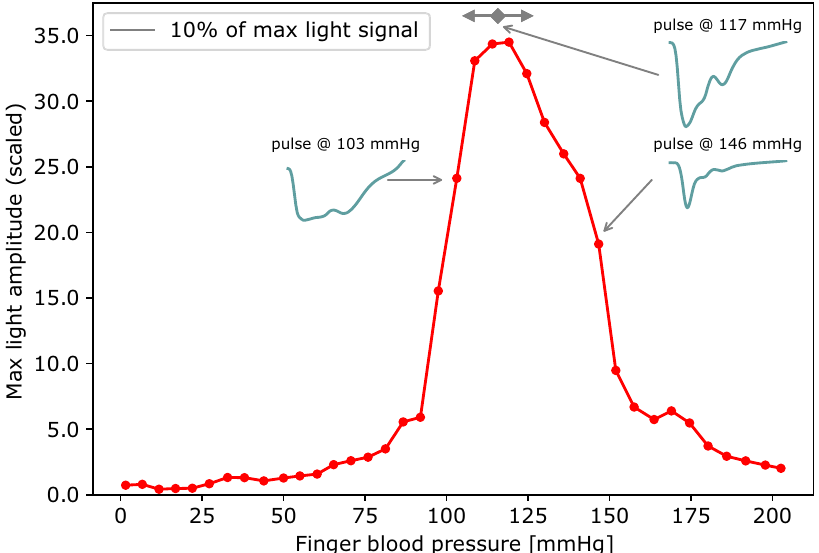
Fig. 11 Shapes of the pulses. The oscillometric wave envelope (red dots and lines) and typical fat, normal and spiky pulses (blue lines) from readings at de fi ned pressure values as denoted in the fi gure. Measurement points (dots) are connected by